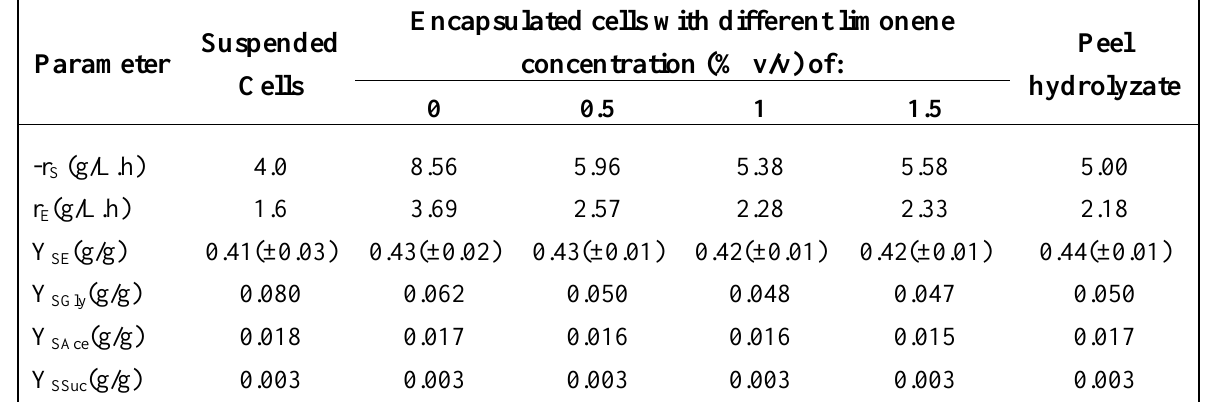
Table 2. Key rates and yields in anaerobic batch cultivation of suspended cells in limonene-free medium and encapsulated cells in media with various concentrations of limonene and peel